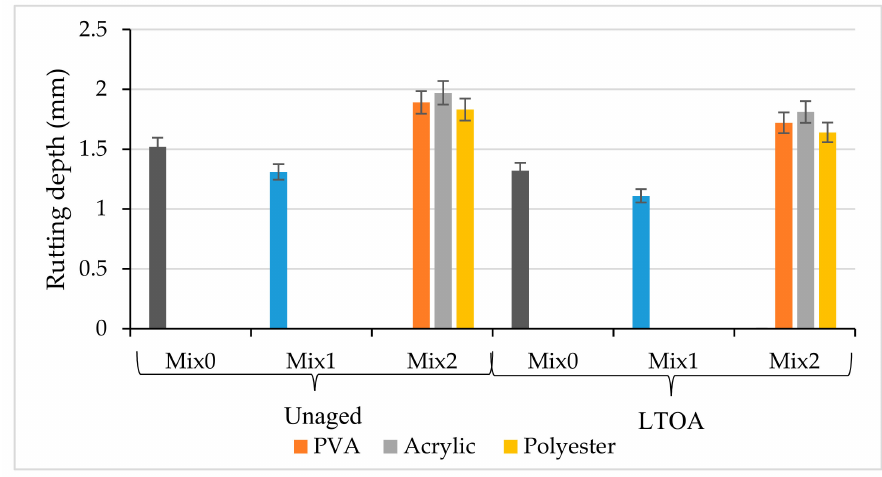
Figure 7. Rutting depth of the asphalt